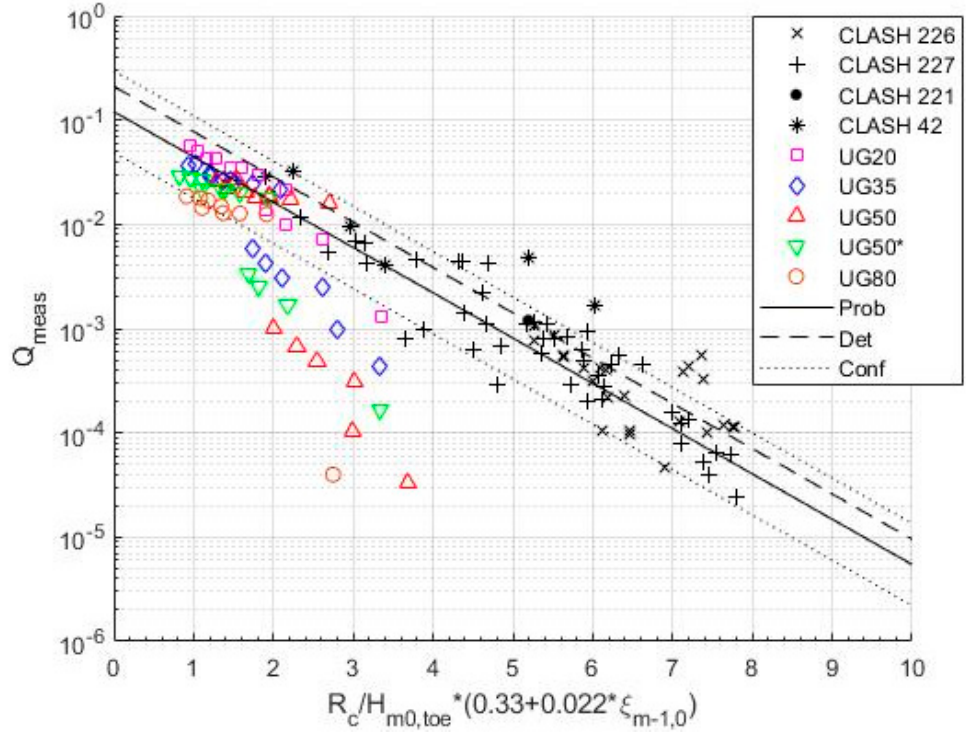
Figure 6. Wave overtopping data and prediction using the Van Gent [12] equations in EurOtop [20] with 5% upper and lower exceedance